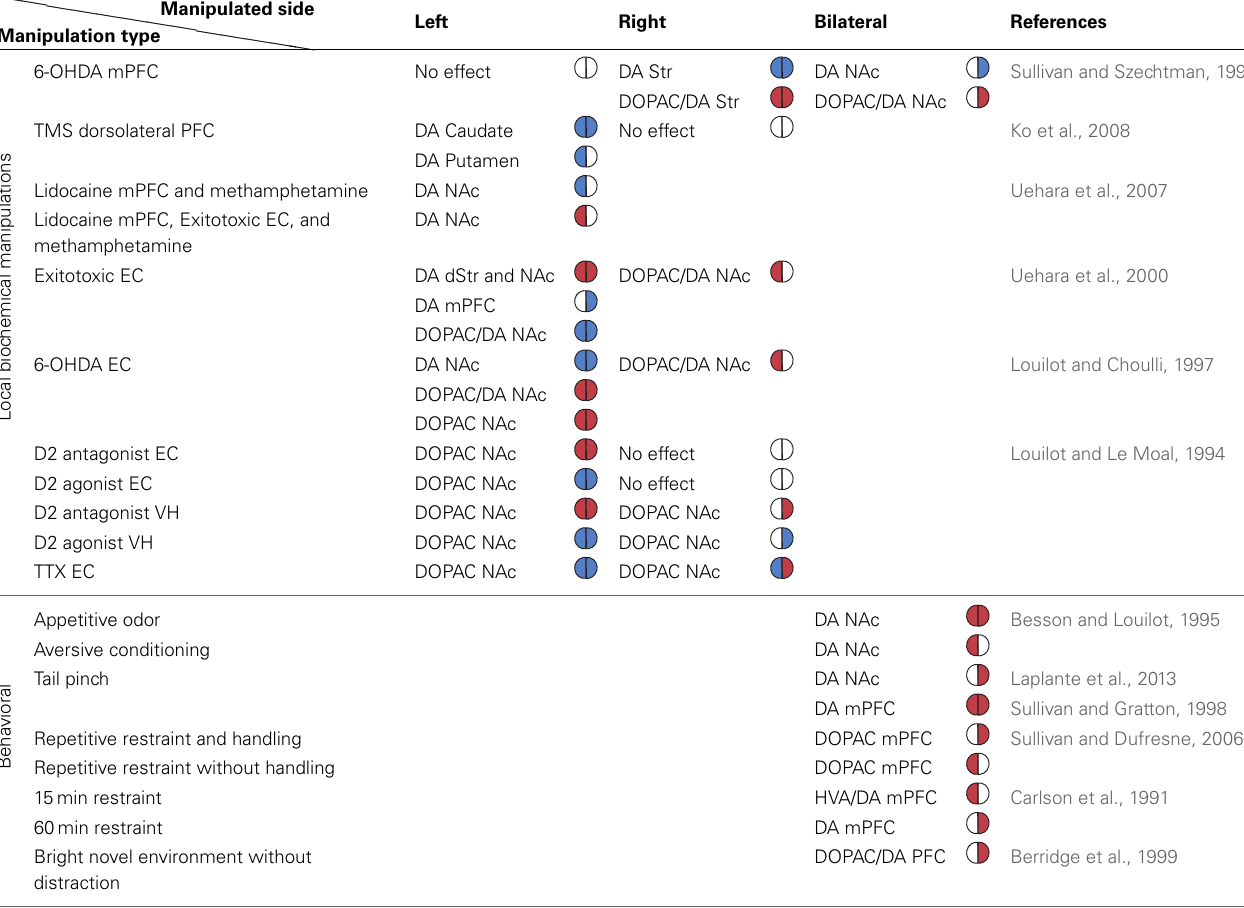
Table 1 | The reported directionality of DA imbalance in the mesolimbic system following biochemical and behavioral manipulations. (cid:2)(cid:2)(cid:2)(cid:2)(cid:2)(cid:2)(cid:2)(cid:2)(cid:2)(cid:2)(cid:2)(cid:2)(cid:2) typeManipulated side Left Right Manipulation